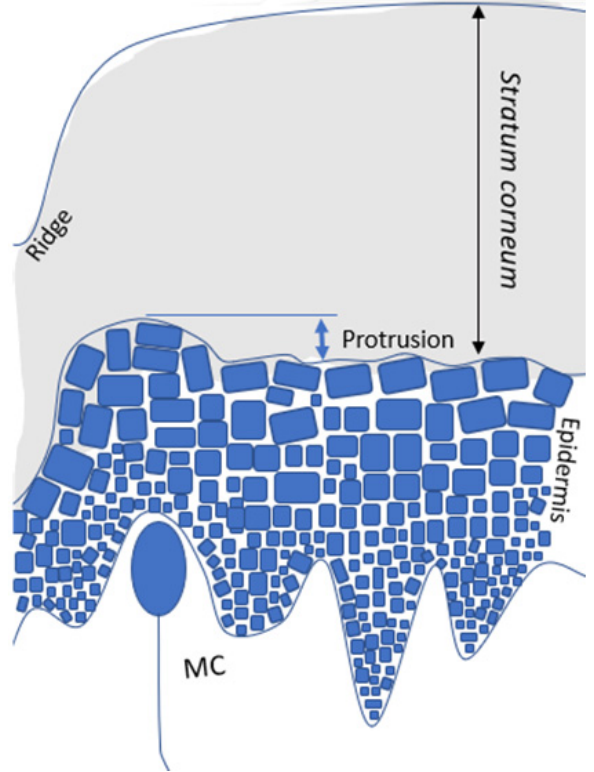
Figure 6. Schematic representation of results. In glabrous skin, Meissner corpuscles (MCs) are co-localized with protrusions of the epidermis into the stratum corneum and with a local reduction in the epidermis thickness.